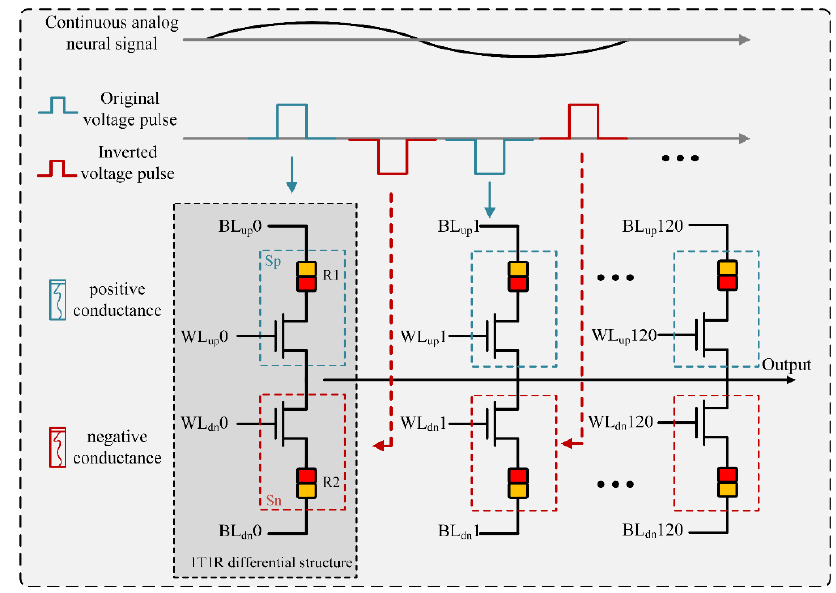
Figure 4. Implementation of the FIR filter for neural activities in an RRAM array.